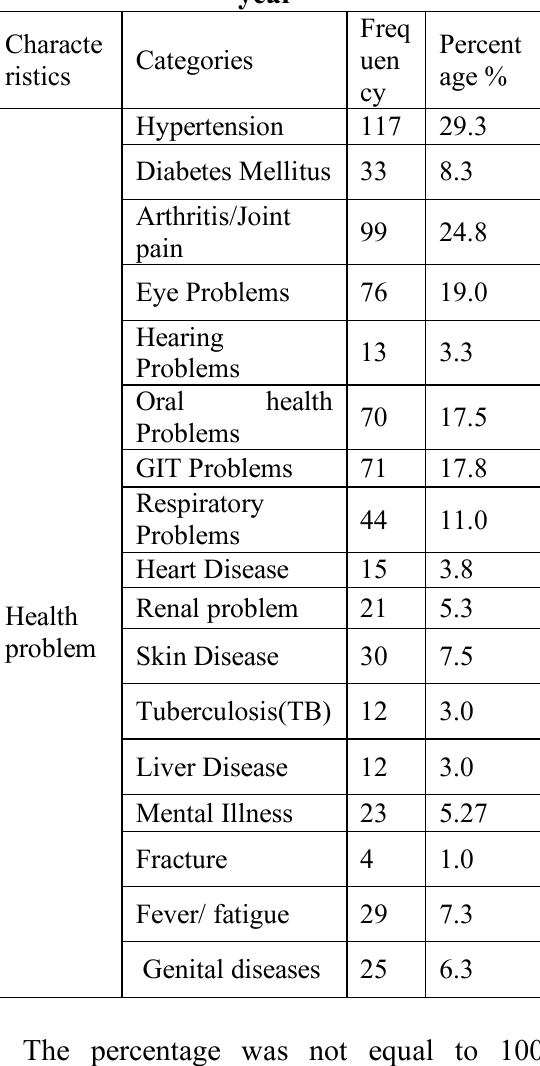
Table 1: Prevalence of reported